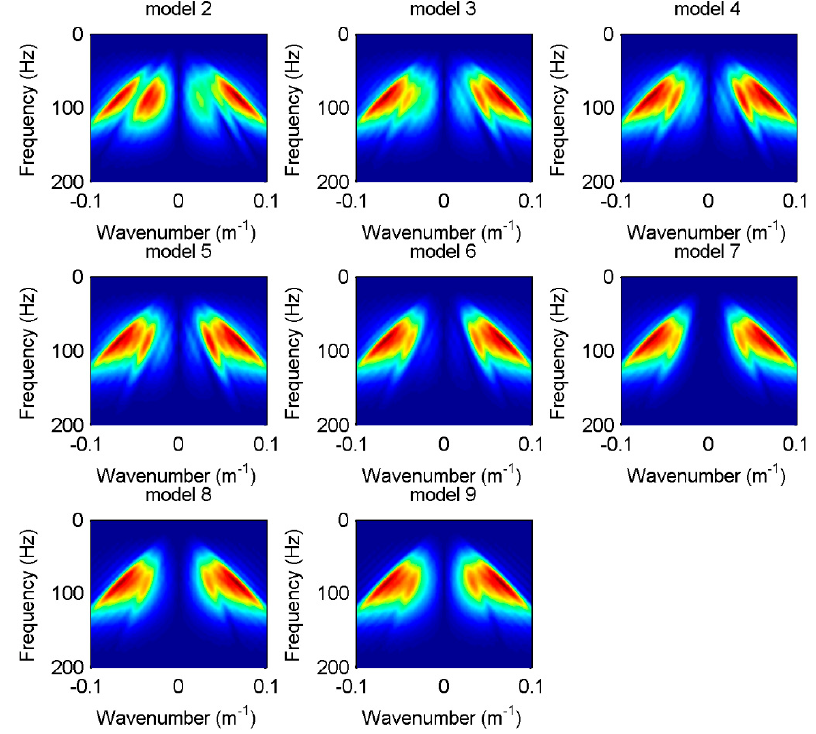
Figure 6. Wave field snapshots of